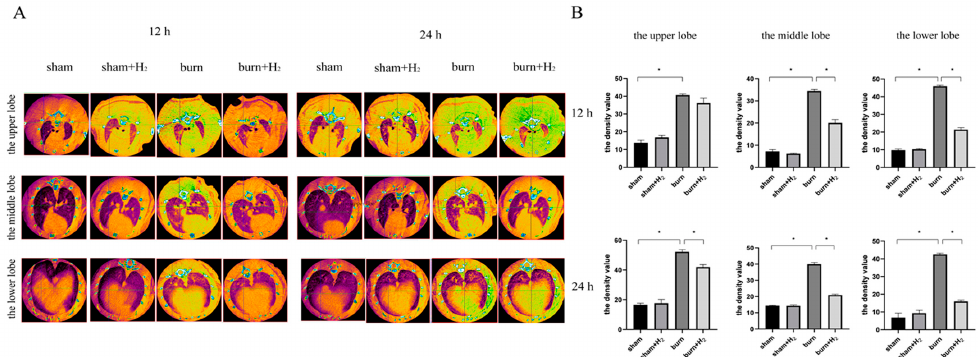
Figure 1. Hydrogen partially reversed the increase in lung tissue density and reduced pulmonary inflammation. The pulmonary inflammation was evaluated by micro-CT ( A ). Average density values for each lobe at 12 and 24 h after injury were analyzed ( B ) ( n = 6 rats per group). * p < 0.05. 3.2. Hydrogen Mitigates Histological Damage to the Lung after a Burn At 12 and 24 h after injury, there was no obvious hyperemia, hemorrhage or inflam- matory cell infiltration in the pulmonary interstitium of rats in the sham and sham + H 2 groups, but there were obvious pathological changes in the lung tissue of rats in the burn group, including pulmonary interstitial congestion, hemorrhage and edema, severe rup- ture of the alveolar capillary wall and extensive infiltration of inflammatory cells. In the burn + H 2 group, the pulmonary interstitial edema was mild, the alveolar capillary was congested with a small amount of rupture and bleeding, and the inflammatory cell infil- tration was less than that in the burn group (Figure 2). Thus, hydrogen had a protective effect on ALI after burn injury.